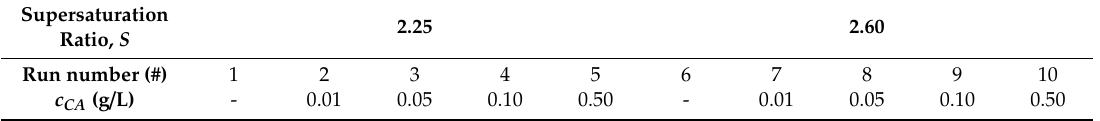
Table 1. Experimental runs for scaling tests with supersaturated calcium